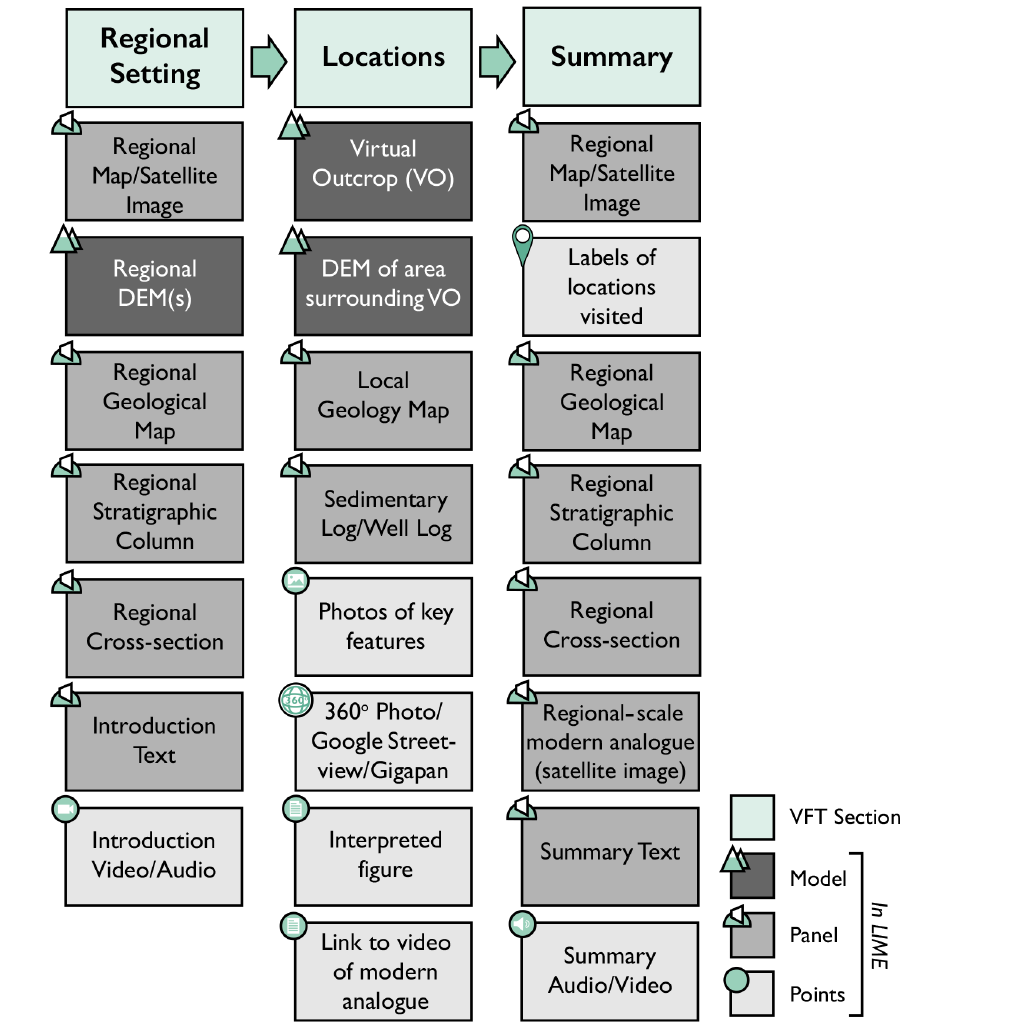
Figure 3. Template storyboard for designing a VFT. Data input within LIME is indicated. Locations varied across each day of each trip, from as few as three locations to as many as eight depending on the days’ aims. Typically, a new location was created for each new virtual